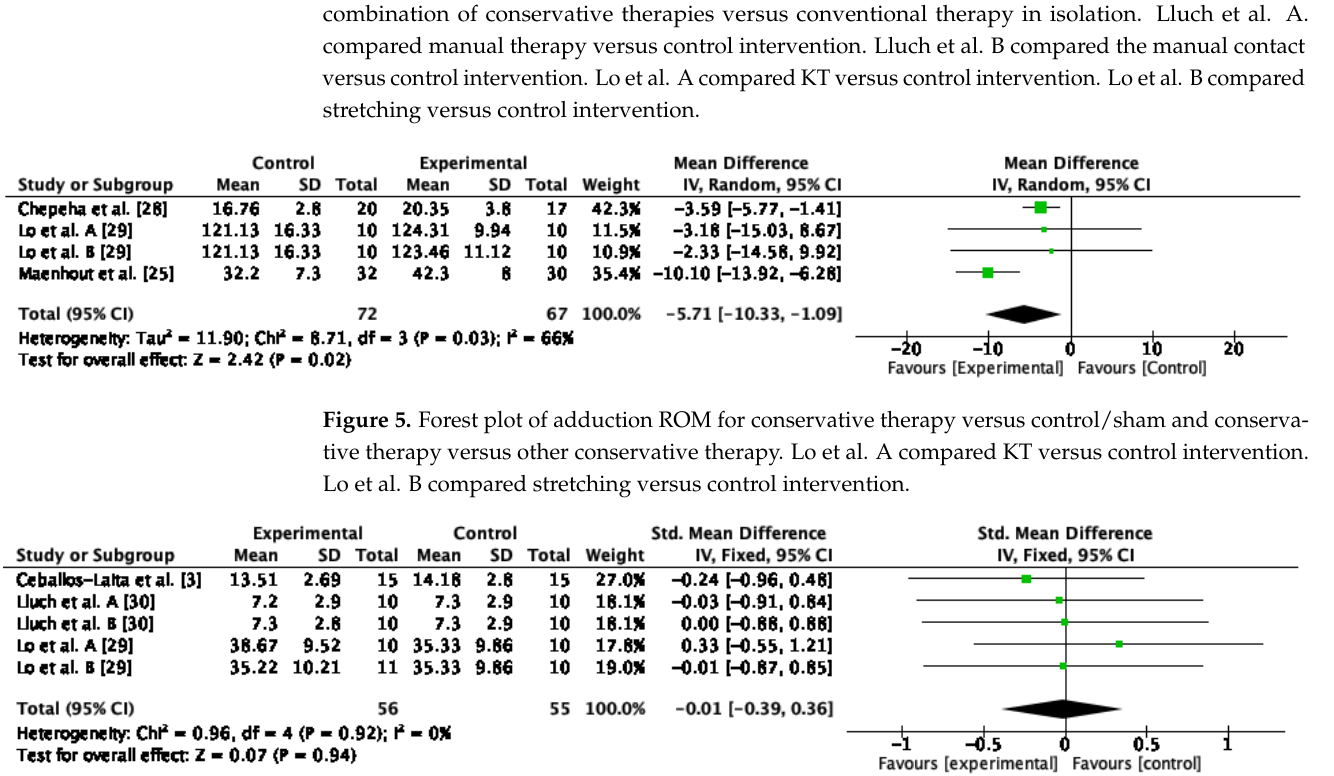
Figure 6. Forest plot of internal rotation strength for conservative therapy versus control/sham. Lluch et al. A. compared manual therapy versus control intervention. Lluch et al. B included the manual contact versus control intervention. Lo et al. A compared KT versus control intervention. Lo et al. B compared stretching versus control intervention.